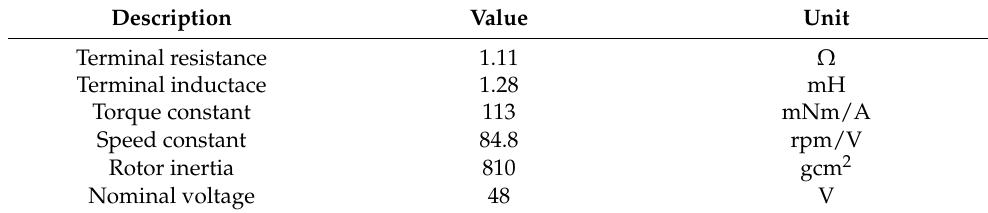
Table 2. Parameters of the applied